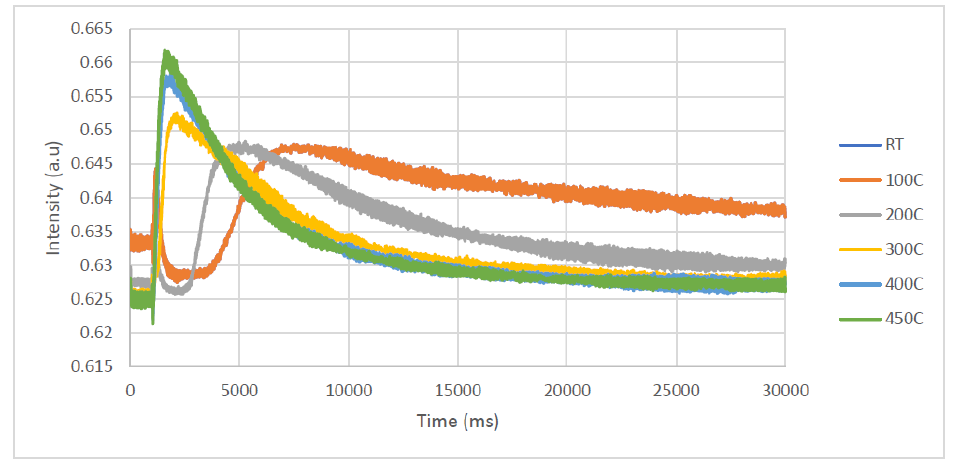
Figure 8. Acetone response to acetone/Ar single-pulse experiments at RT, 100, 200, 300, 400, and 450 °C over the 5 mg catalyst. Table 4. Calculated residence time for H 2 , acetone, and Ar responses in an empty TAP reactor along with their responses over the catalyst at RT, 100, 200, 300, 400, and 450 ◦